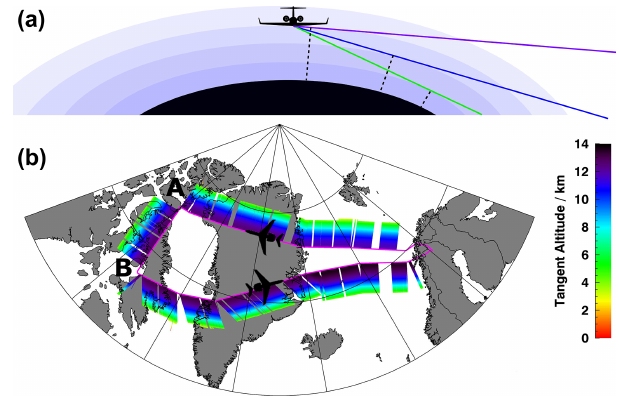
Figure 1. (a) Schematic representation of airborne limb view- ing geometry. (b) GLORIA sampling during PGS14 on 26 Febru- ary 2016. The tangent points of the GLORIA limb views are colour- coded with altitude. Characteristic waypoints are marked “A” and “B”.